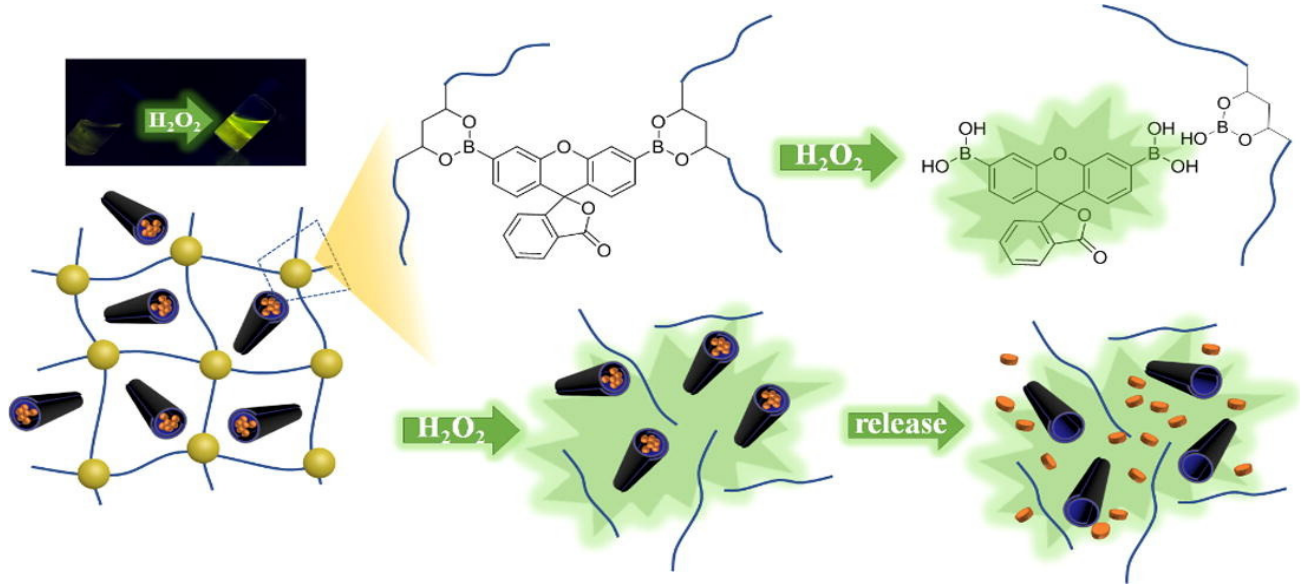
Figure 3. Schematic of the mechanism of release when hydrogel under pathological concentration. Reprinted by permission of the publisher.